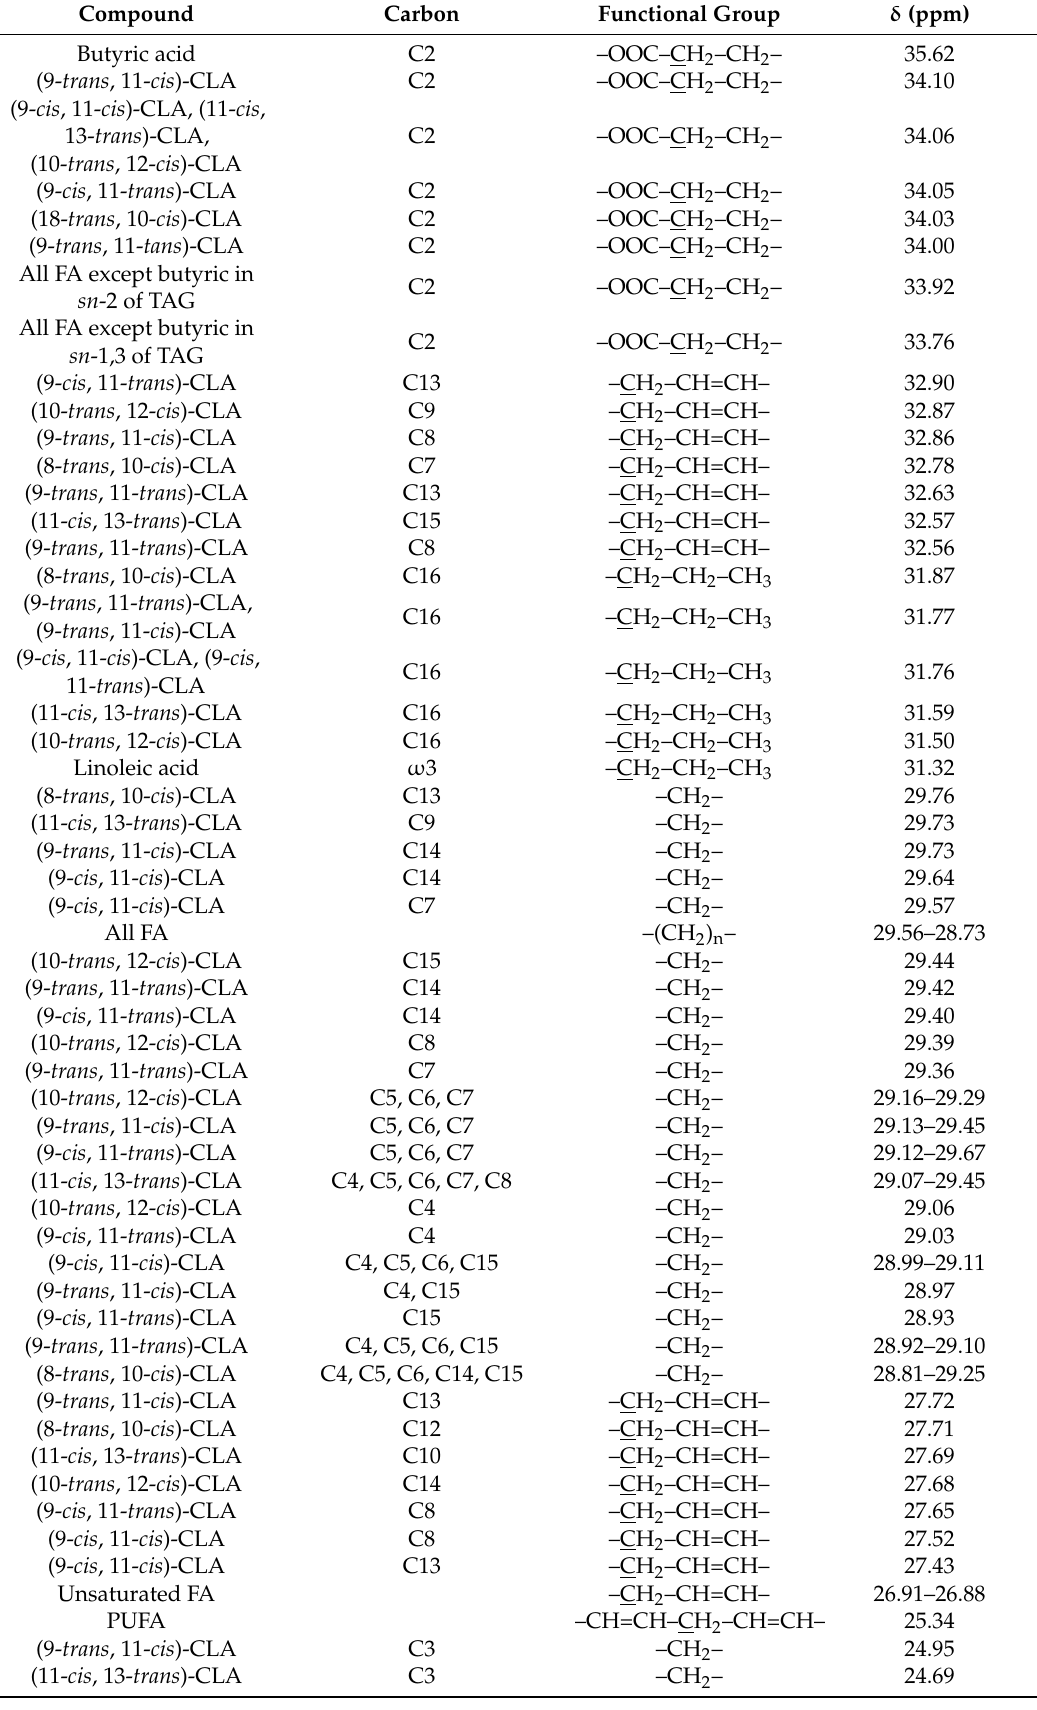
Table 17. 13 C-NMR peak assignment of the aliphatic carbons of lipids in CDCl 3